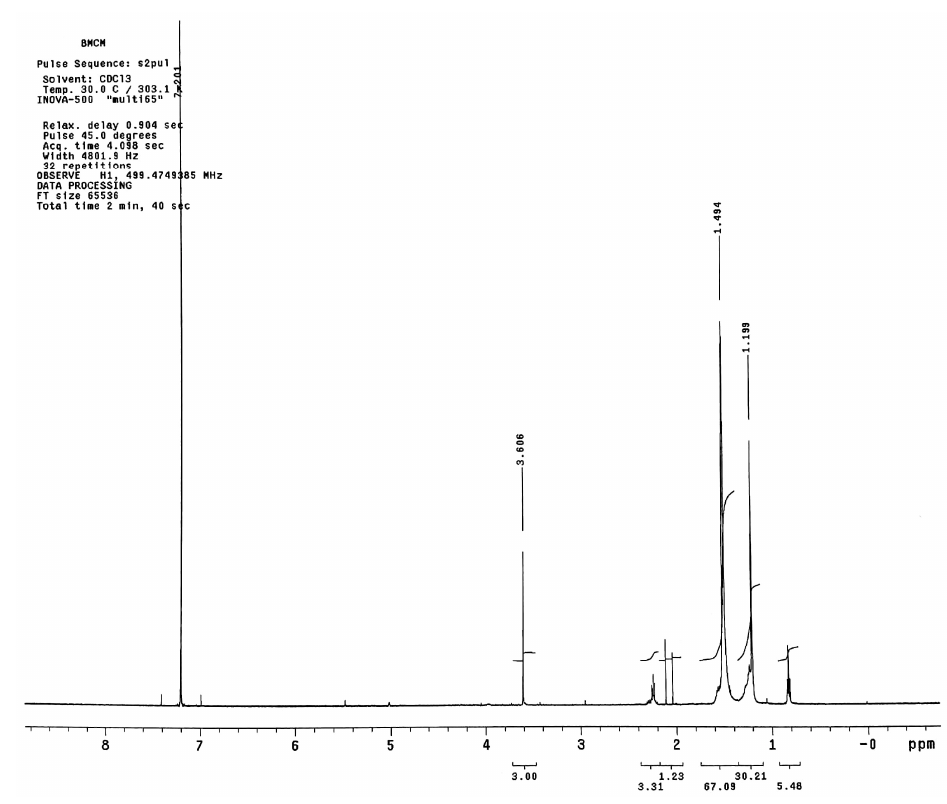
Figure 4. 1 H-NMR spectrum of methyl biodiesel of B. glabra degummed oil with H 3 PO 4 (CDCl 3 , 500 MHz).